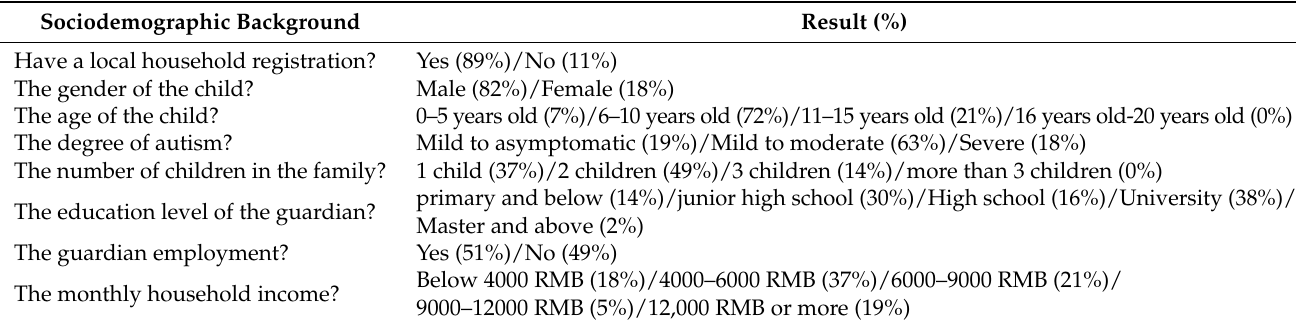
Table 5. The sociodemographic background characteristics of ASD